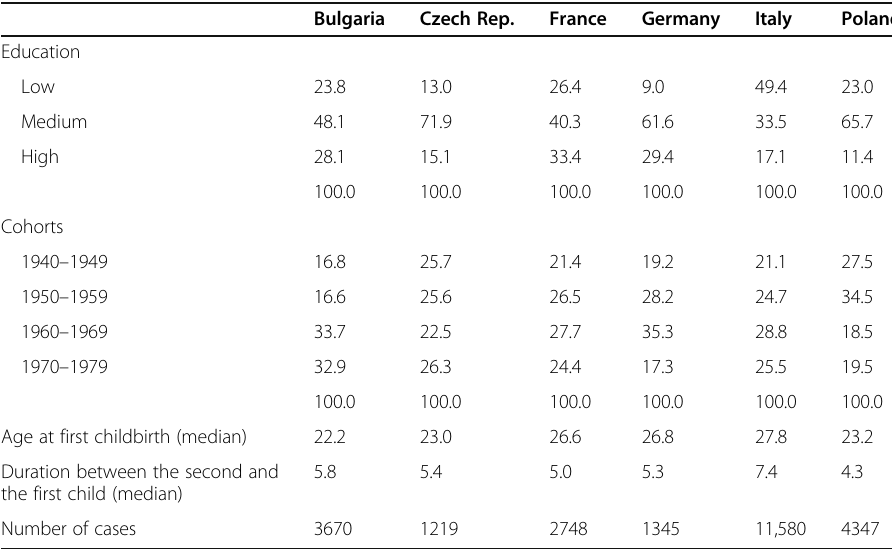
Table 1 Percentage of women by level of education and birth cohort, median age at the first childbirth and median duration between the first and the second childbirth by country Bulgaria Czech